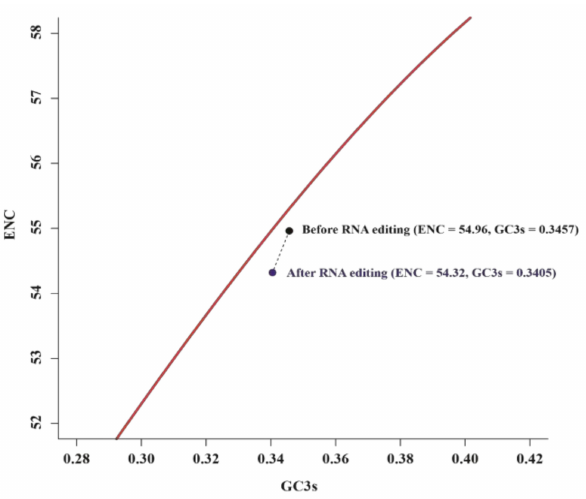
Figure 4. The ENC-GC3s plot of mitochondrial PCGs at overall level before and after RNA editing. The red line represents the expected ENC curve (ENC expected = 2 + GC3s + 29/[GC3s 2 + (1 − GC3s) 2 ]). In addition, the regression coefficient (0.07315) before RNA editing in the neutrality plot showed that the contribution of mutation pressure was 7.315% (Figure 5). By contrast, that value had decreased dramatically (0.00033) after RNA editing, implying the degree of mutation pressure dropped to 0.033% (Figure 5).